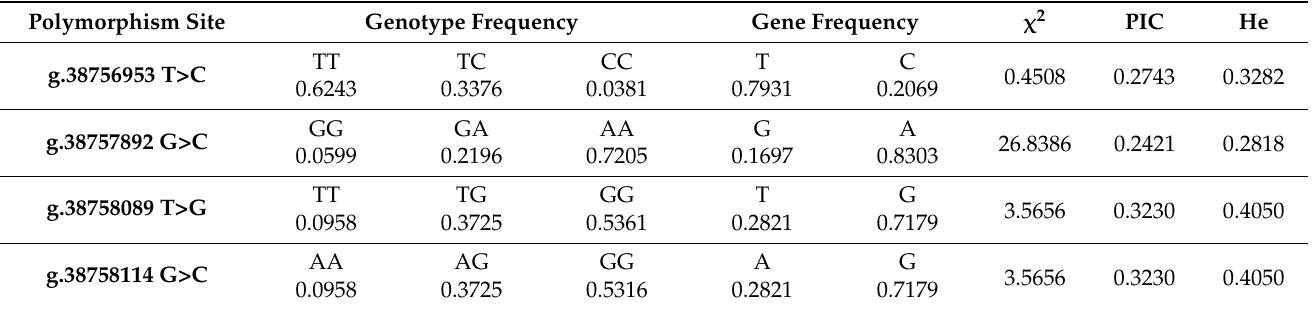
Table 3. Population genetic characteristics of SNPs of GLIPR1.